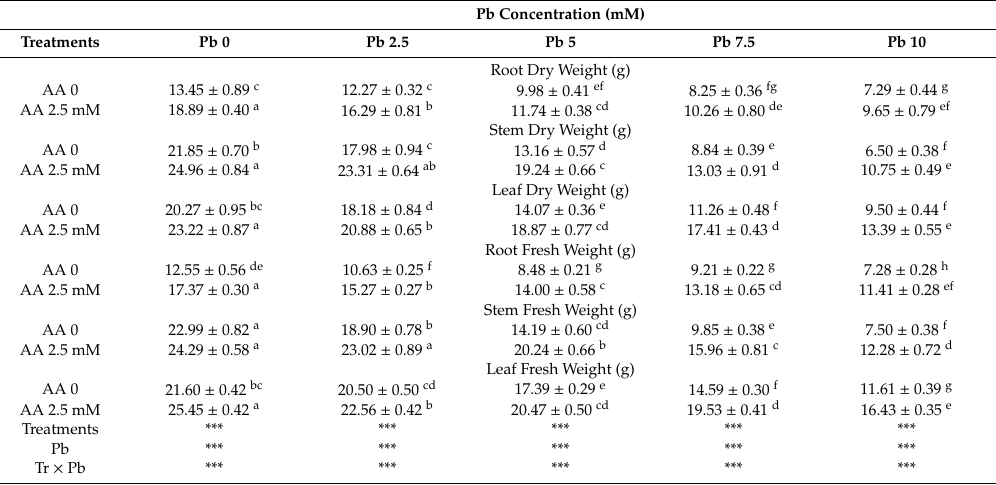
Table 1. E ff ect of Pb (0, 2.5, 5, 7.5 and 10 mM) with and without AA (2.5 mM) on fresh and dry biomass of leaf, stem and root of A. bettzickiana .